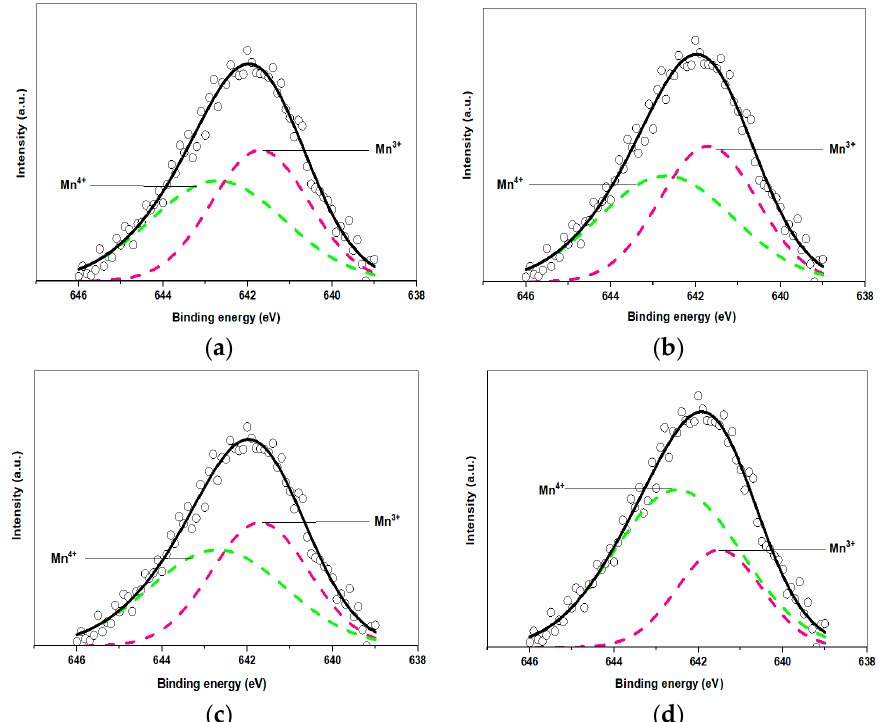
Figure 5. The Mn 2p of the XPS spectra for ( a ) Sample (a), ( b ) Sample (b), ( c ) Sample (c), and ( d ) Sample (d).